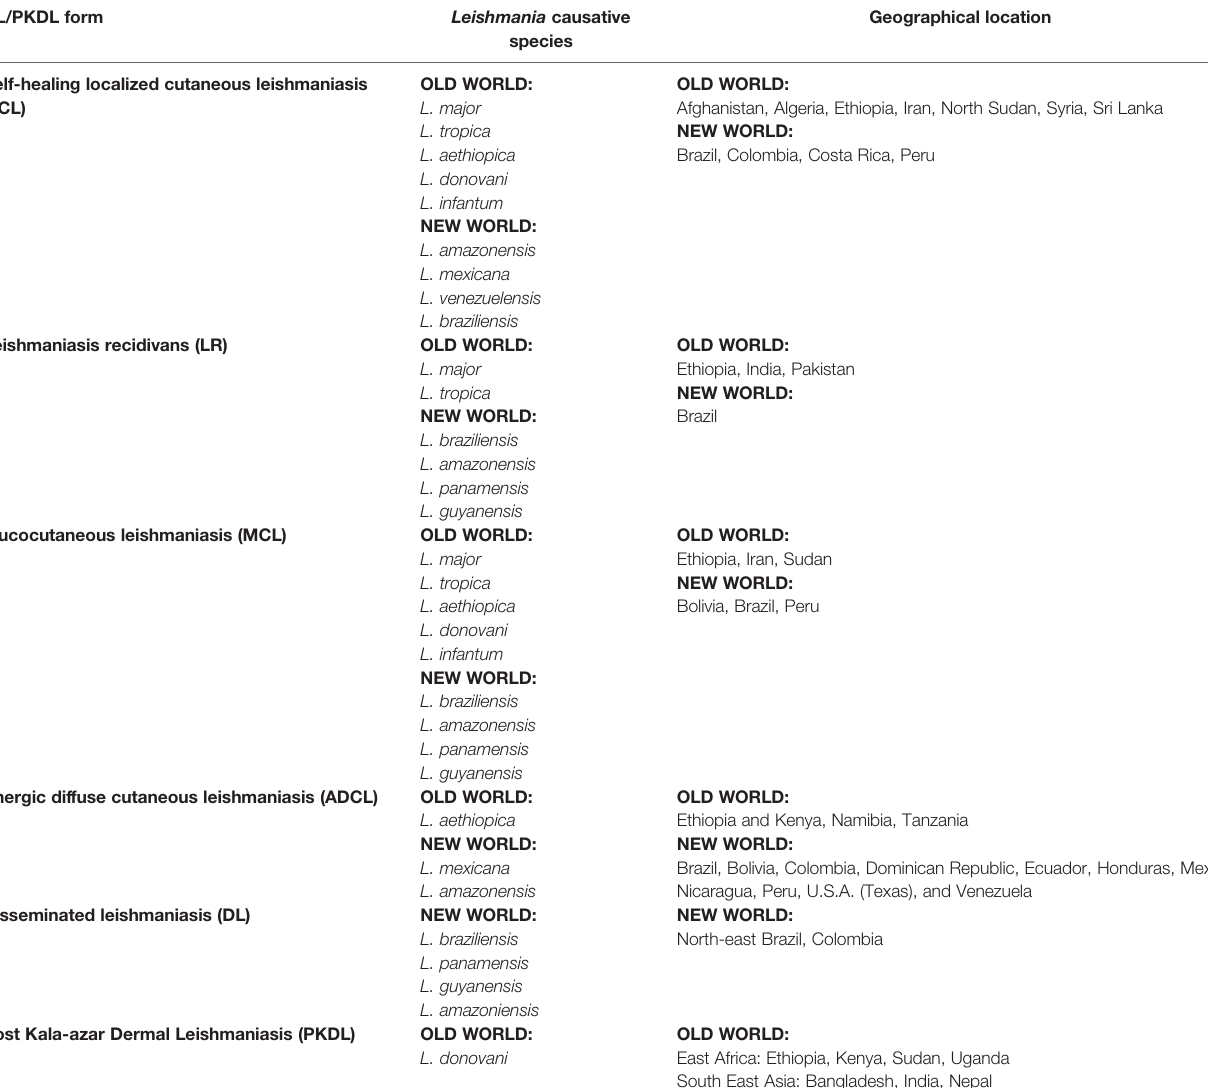
Geographical location